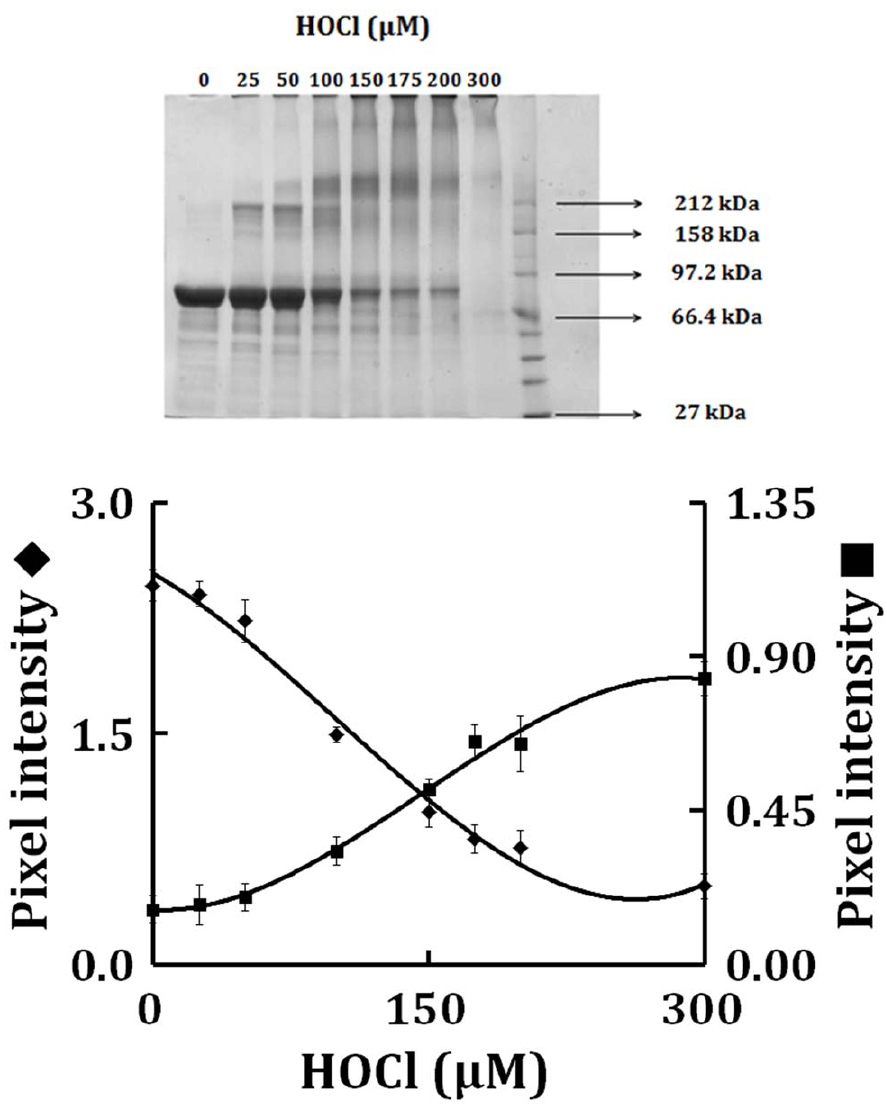
Figure 6. Protein aggregation of LPO treated with different HOCl concentrations. Upper panel depicts the reducing SDS-PAGE of LPO treated with HOCl, showing a decrease in the main LPO band, and a concomitant increase of high molecular weight aggregates. Lower panel displays a plot showing the variations of pixel intensity of LPO monomer (closed diagonal) and high molecular weight aggregates (closed square) as a function of HOCl concentration. Reaction was carried-out by mixing a buffered solution of LPO (1.5 m M final) with HOCl, and the gel was run after 60 minutes incubation, at 25 u C. These data are representative of three independent experiments.